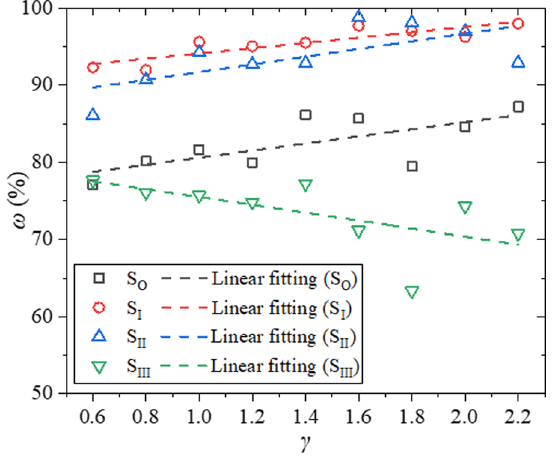
Fig. 21 Variation of pure coal recovery ratio with γ at different